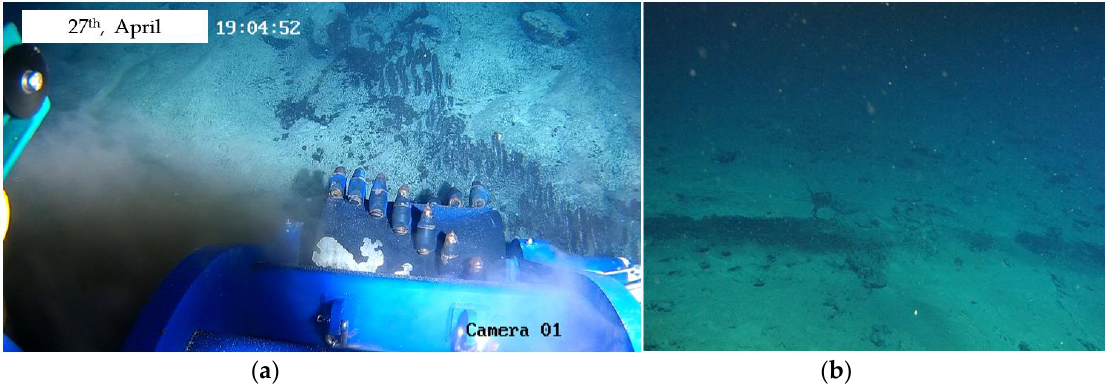
Figure 21. Grooves after crushing. ( a ) 2019 Sea trial (From vehicle), ( b ) 2020 Sea trial (From Manned Submersible).